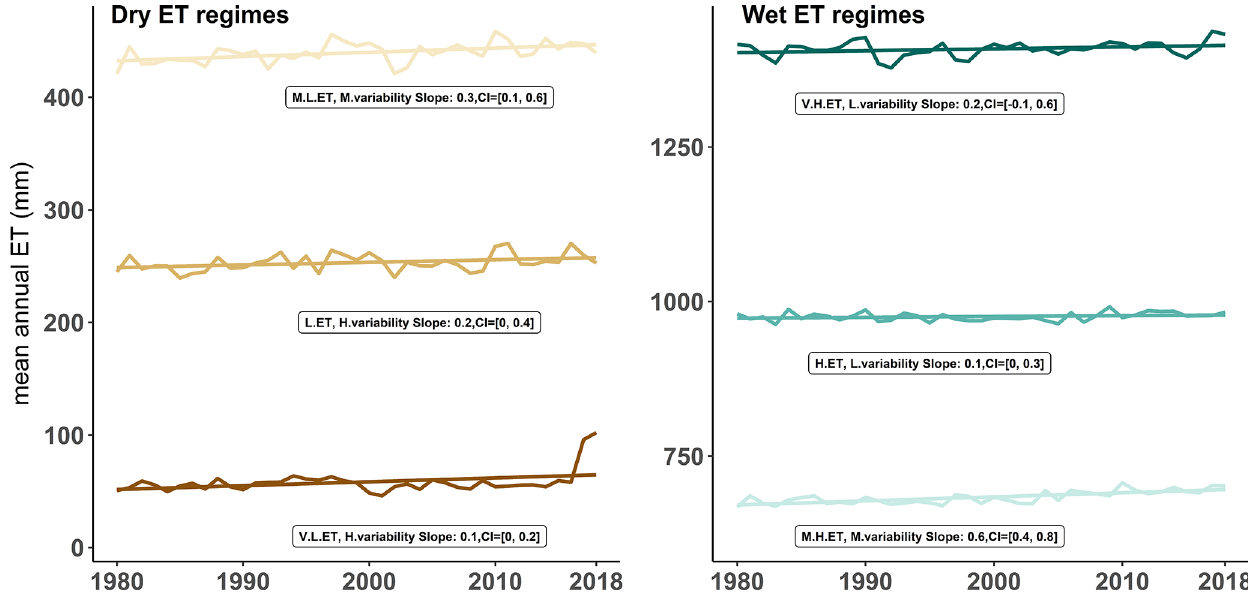
Figure 7. Trends in mean annual ET total computed for the dry and wet ET regimes during 1980–2018. Slopes and confidence intervals are computed using Mann–Kendall and Sen’s slope methods. The spatial distribution of the ET regimes is illustrated in Fig. 6. Table 4. Correspondence between ET regimes derived here and Köppen climate classes derived in Chen and Chen (2013). Text in bold font indicates that the Köppen climate is associated with more than one ET